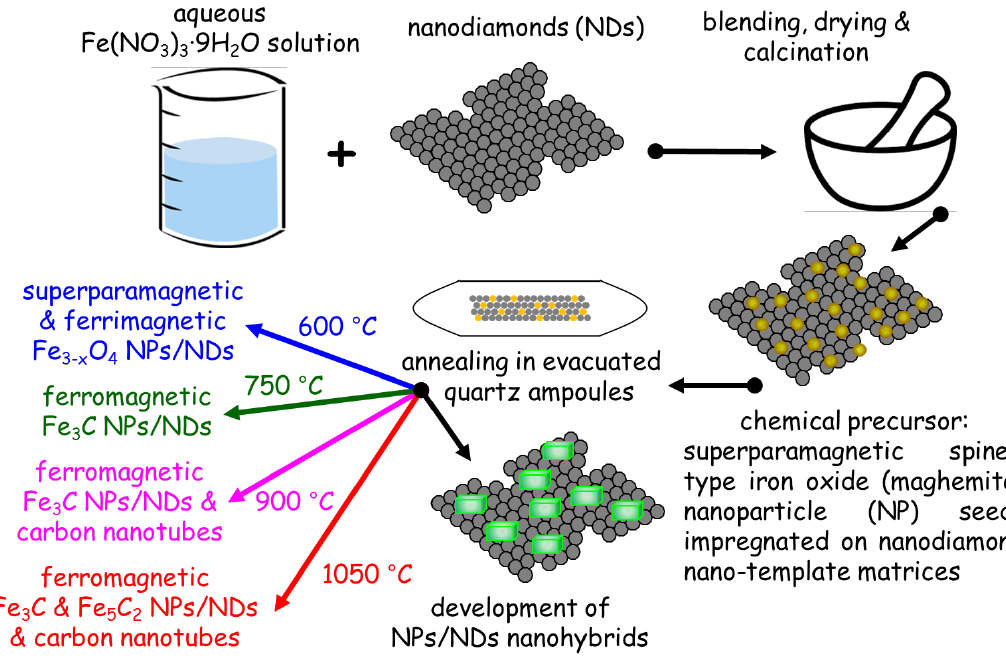
Figure 1. Schematic representation of the synthesis stages followed and the resulting nanohybrid samples produced in this work.